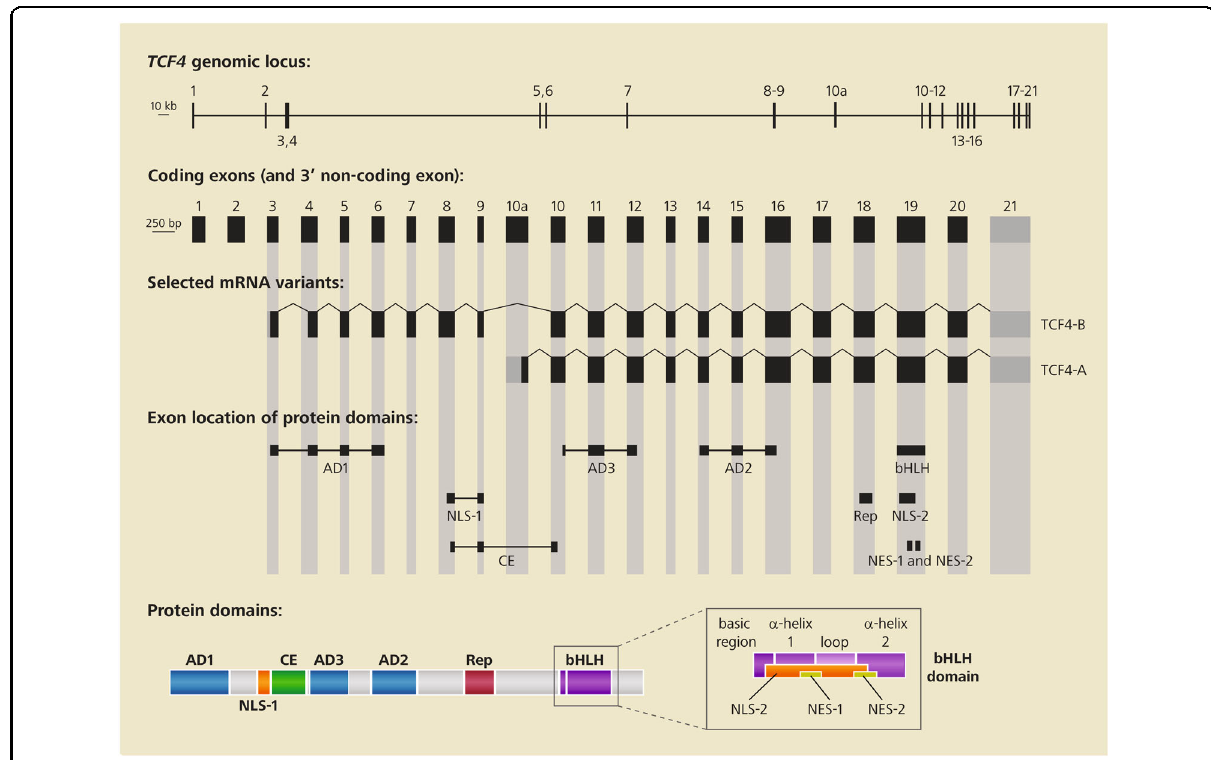
Fig. 1 Schematic representation of the TCF4 genomic locus. The genomic locus is located on chromosome 18 (top line; exon sizes and distances between exons shown to scale), coding exons (middle lines; exon sizes, but not distances, shown to scale), and TCF4 protein domain structure (bottom line; domain sizes not to scale). The last exon on the right, displayed in gray, is non-coding. Only transcript variants coding for isoforms TCF4- B and TCF4-A are shown, which are transcribed from alternative promoters starting at exons 3 and 10, respectively. AD activation domain, NLS nuclear localization signal, NES nuclear export signal, bHLH basic helix – loop – helix DNA-binding domain, CE conserved element, Rep repression domain. In the bottom line, the protein motifs inside the bHLH domain are shown in detail in the enlarged inset. Based on refs. 22,61